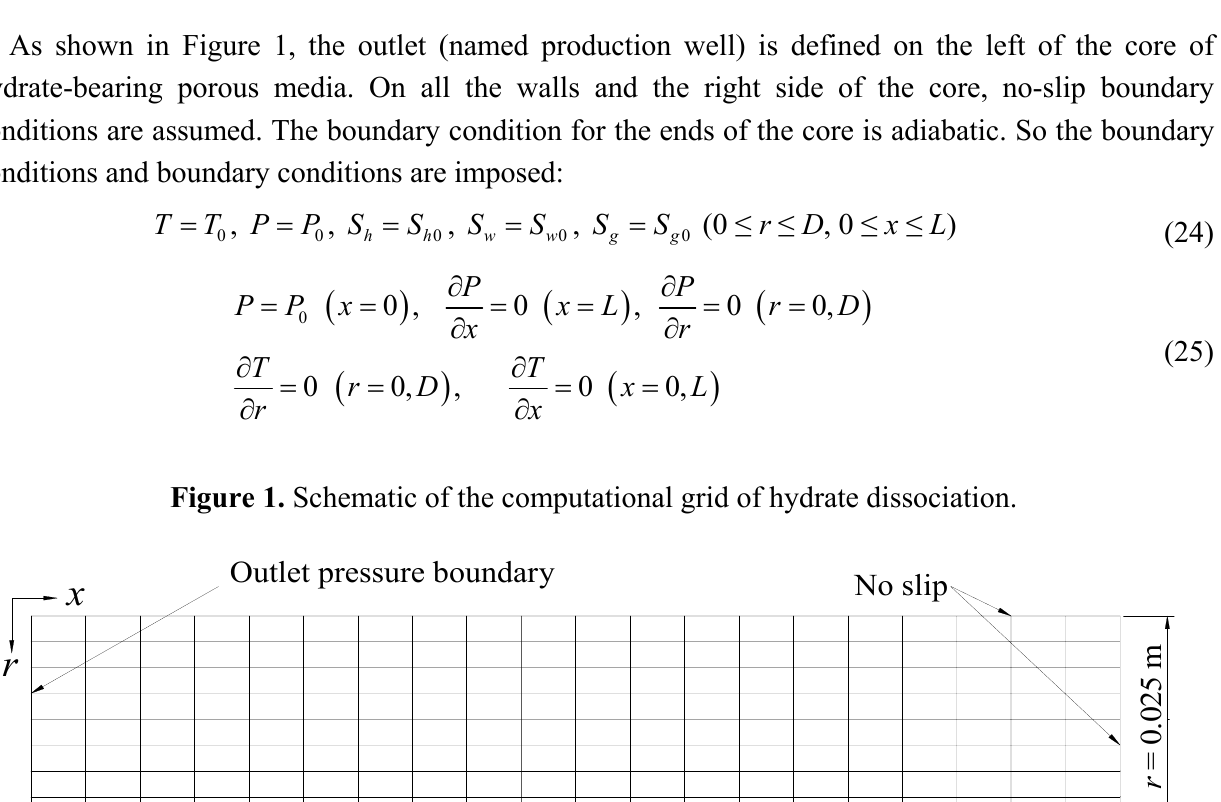
Axis of symmetry